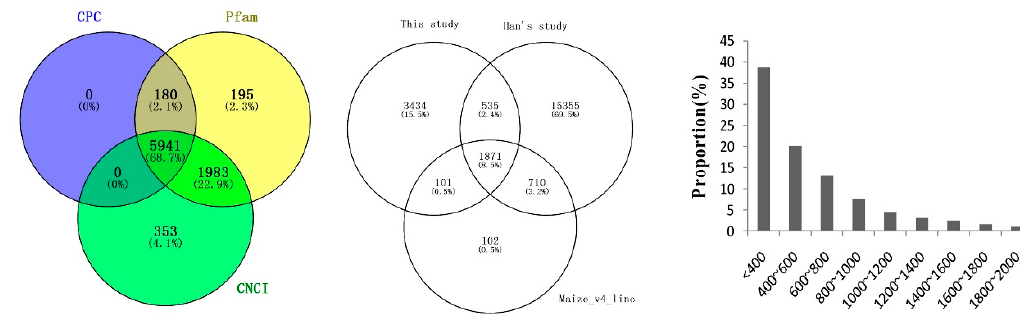
Figure 4. Venn diagram (left) of the number of noncoding transcripts, comparison of long noncoding RNAs (lncRNAs, middle) and distribution of lncRNAs (right).